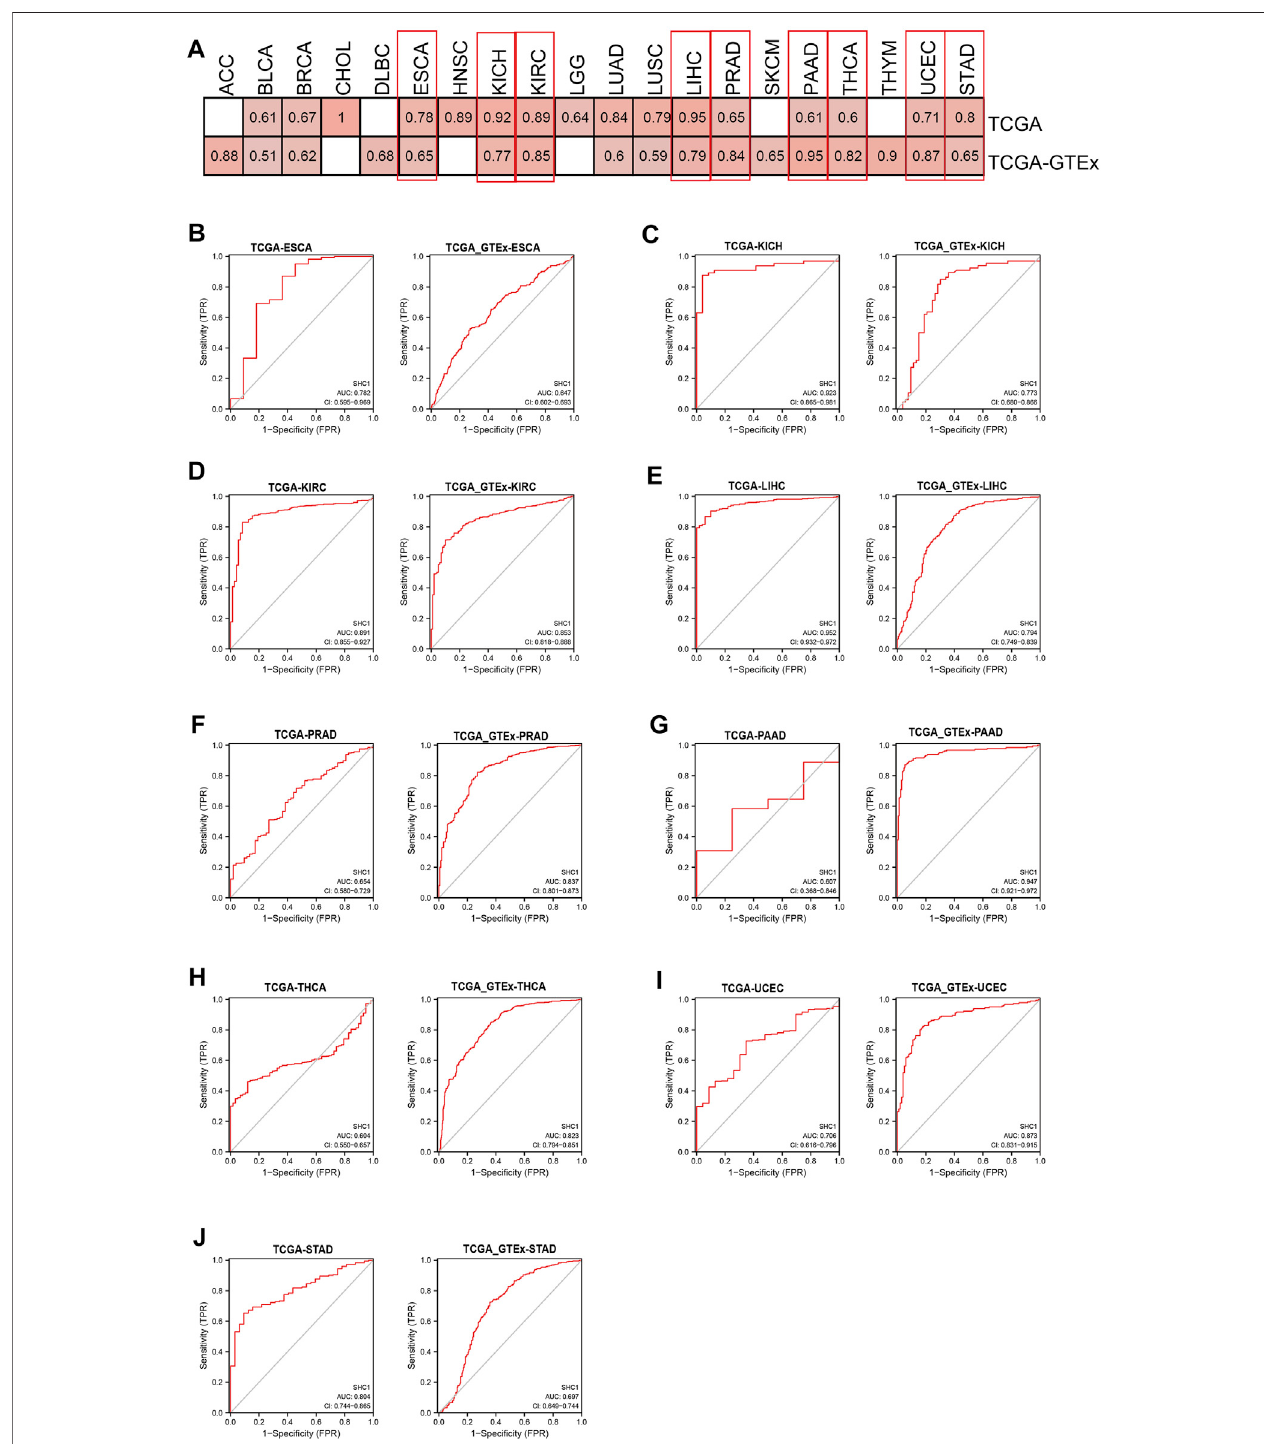
FIGURE 10 | Diagnostic ef fi ciency of SHC1 gene in different tumors. (A) The heatmap shows the AUC values of SHC1 gene expression level in the diagnosis of various cancers. The ROC curve of SHC1 gene in diagnosis of ESCA (B) , KICH (C) , KIRC (D) , LIHC (E) , PRAD (F) , PAAD (G) , THCA (H) , UCEC (I) , and STAD (J) using the TCGA and TCGA-GTEx